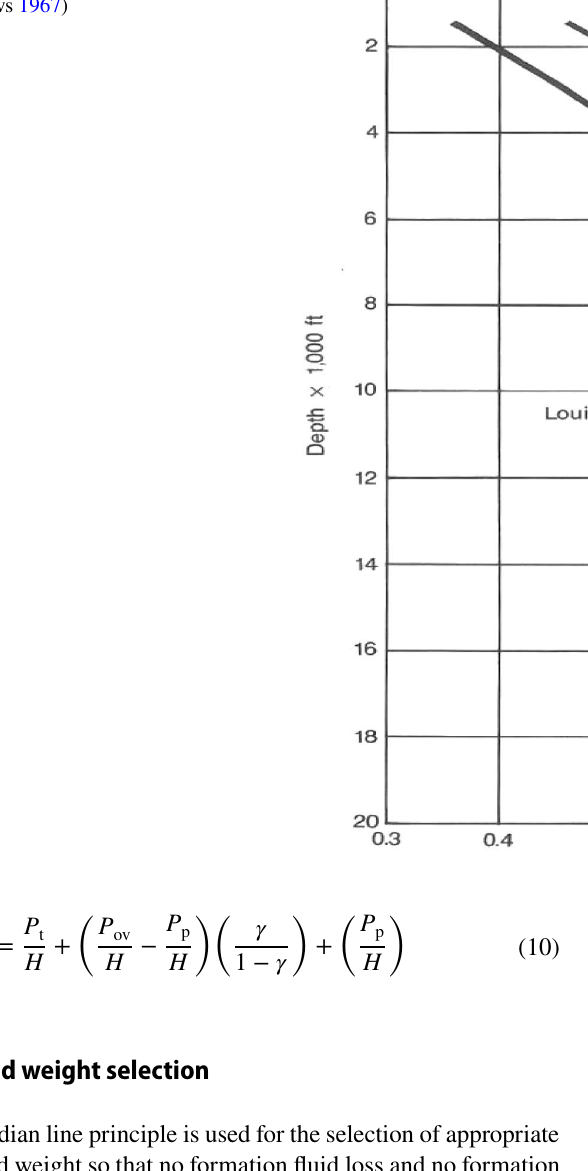
Fig. 5 Matrix stress coefficients of Matthews and Kelly (Mat- thews